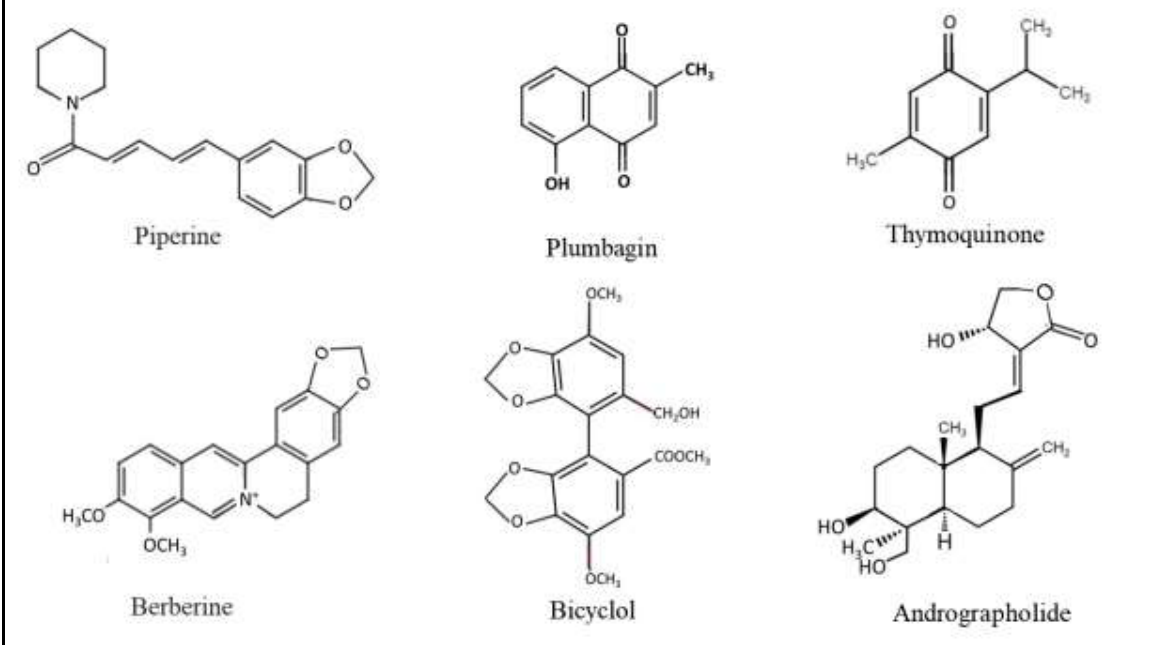
Figure 2. Chemical structures of some common phytochemicals Phytochemicals and immune